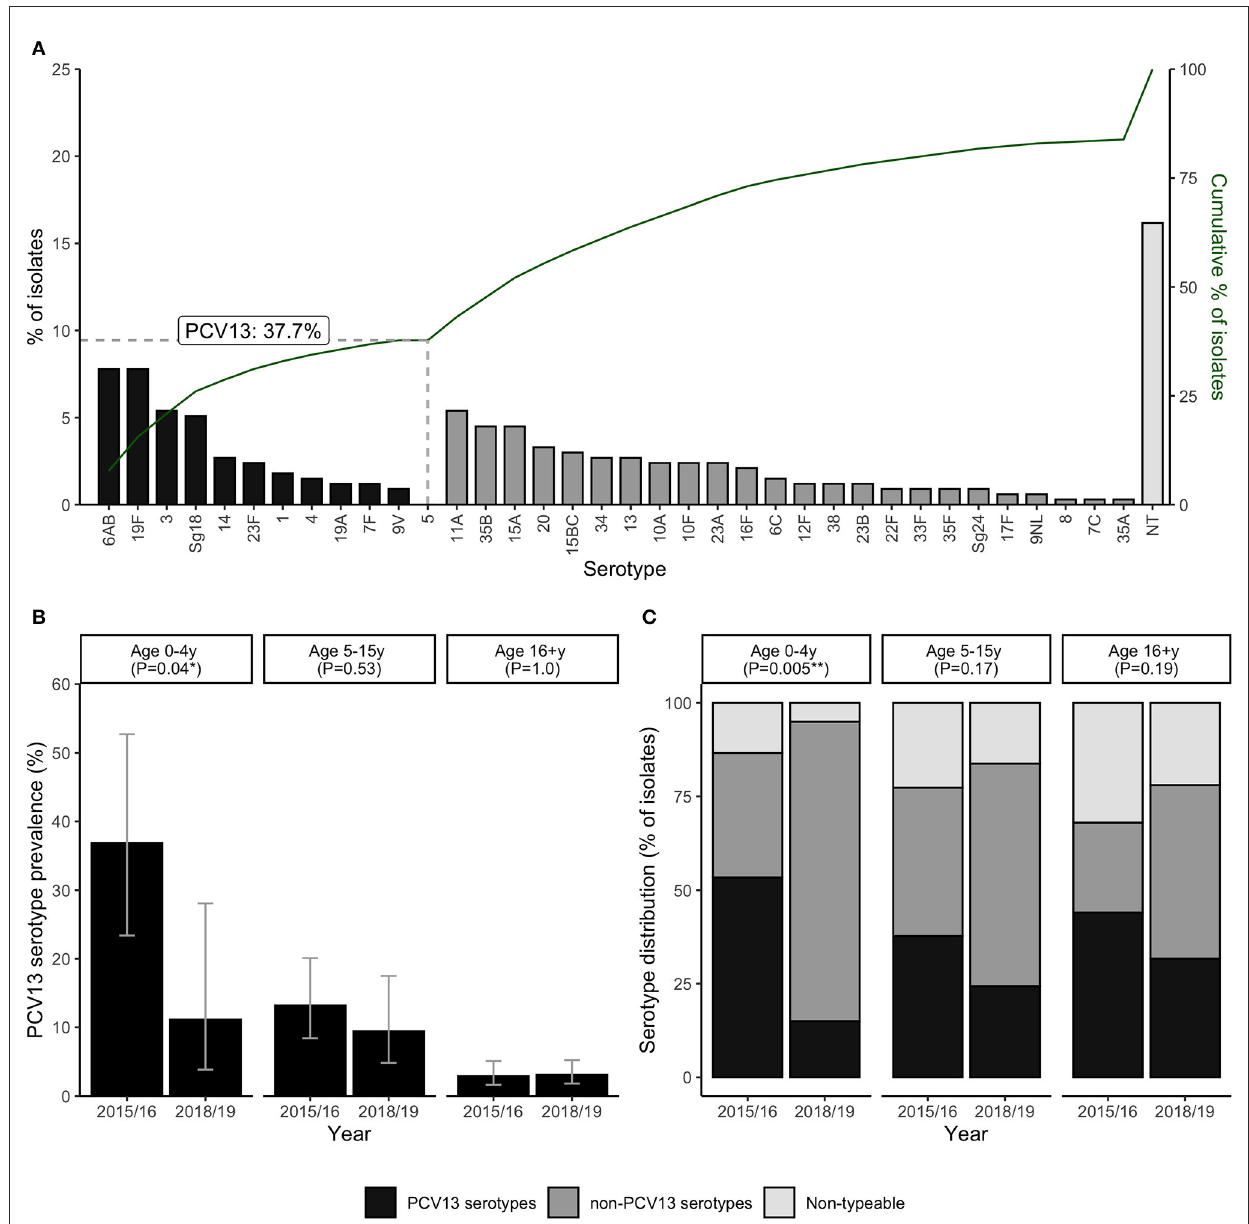
FIGURE2 Carriage of pneumococcal vaccine (PCV13) and non-vaccine serotypes among ILI cases ( n = 1,621). Panels show the percentage distribution and cumulative distribution of pneumococcal isolates by individual serotype (A) ; PCV13 serotype carriage by age group and surveillance year (B) ; and the percentage of pneumococcal isolates in each serotype category by age group and surveillance year (C) . P -values in panels B, C are derived from Chi-squared tests for differences between surveillance years. Error bars in panel B represent exact 95% confidence